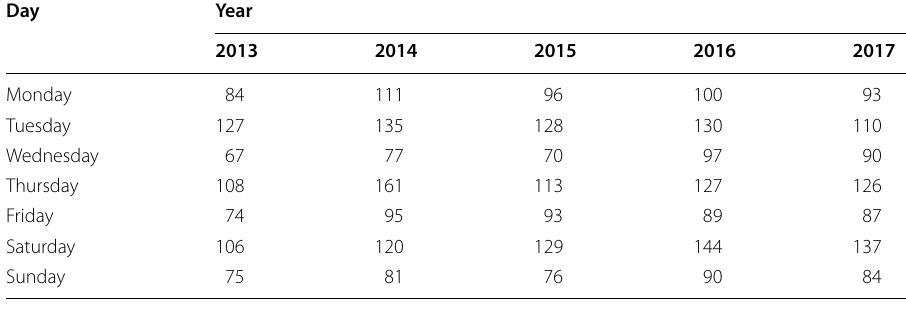
Table 3 Total Number of accidents in Amhara region (September 2013 to May 2017) by days of the